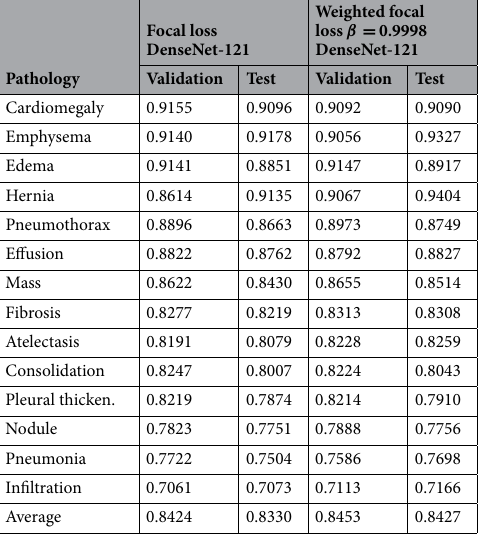
Table 5. The improvement of the proposed weight calculation.